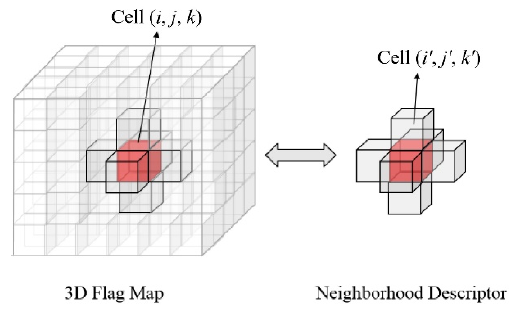
Figure 3. Three-dimensional flag map and descriptor.